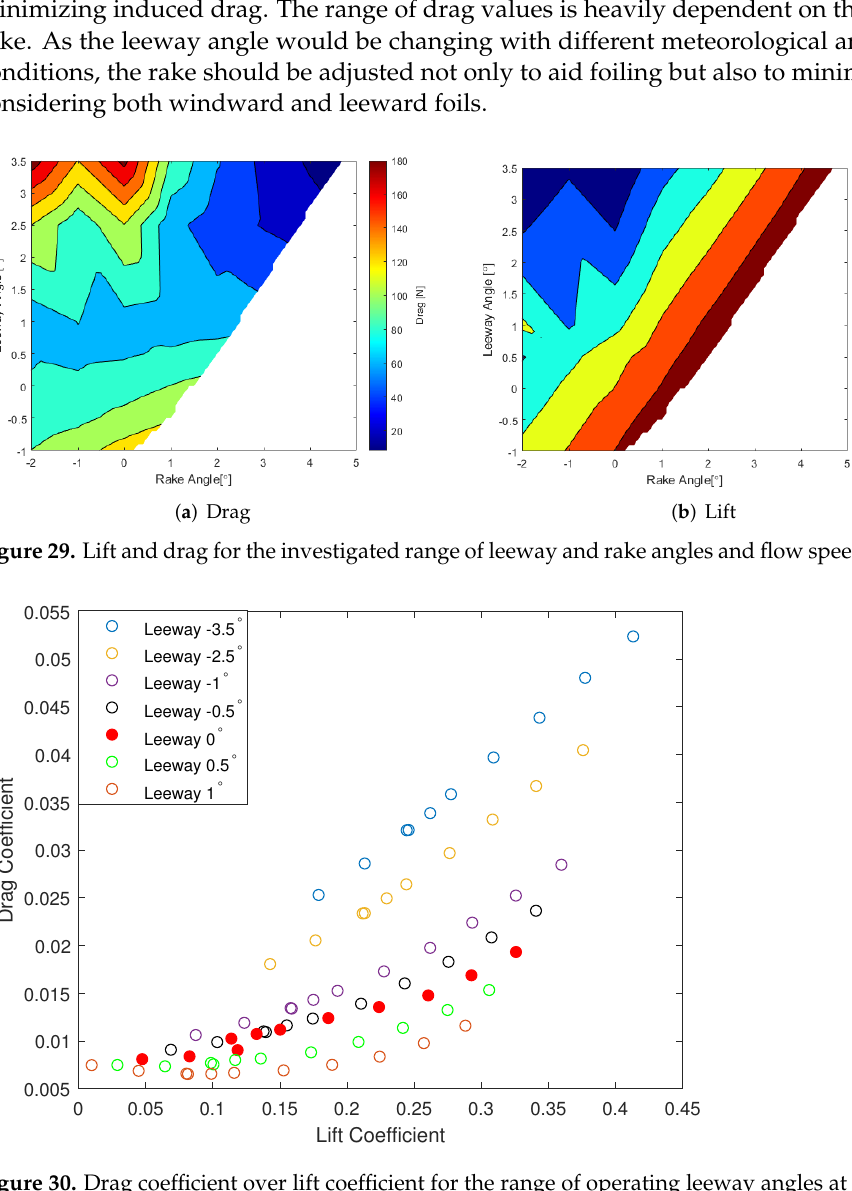
Figure 30. Drag coefficient over lift coefficient for the range of operating leeway angles at flow speed of 5